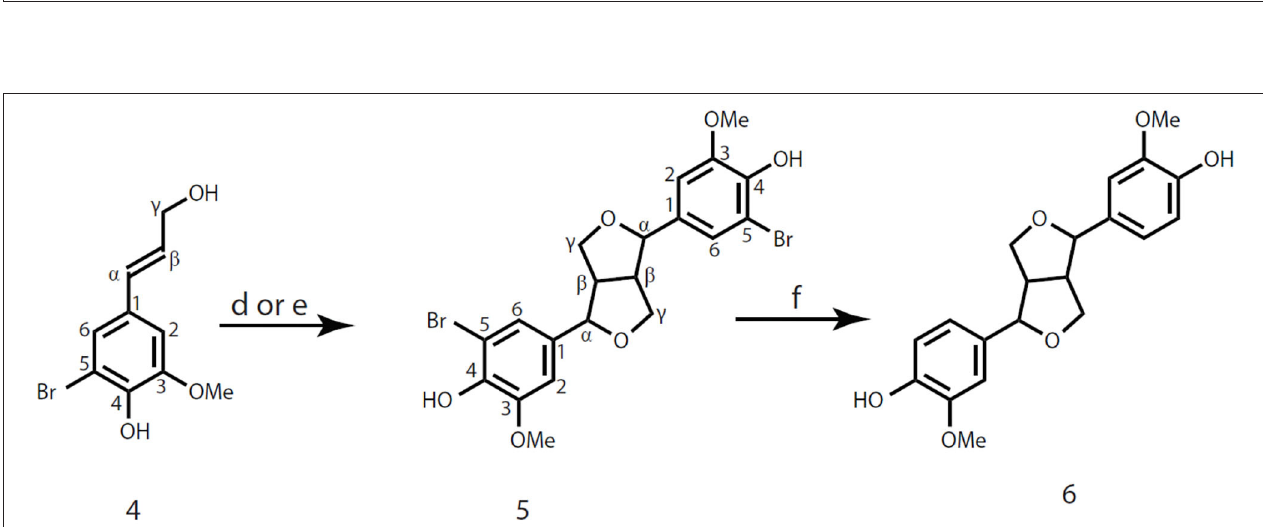
Frontiers in Energy Research | www.frontiersin.org